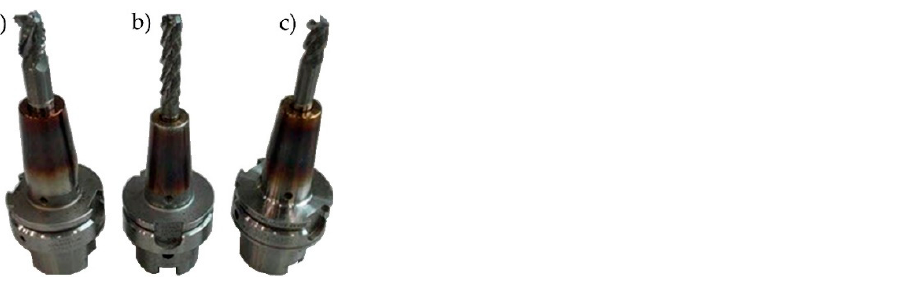
Figure 4. Machining tools: ( a ) SGS Tools 44303, ( b ) SGS Tools 44631, and ( c ) SEGER F103AL-120. Table 2. Technical data of the machining tools used (own elaboration, based on [49,50]). Tool SGS Tools 44303